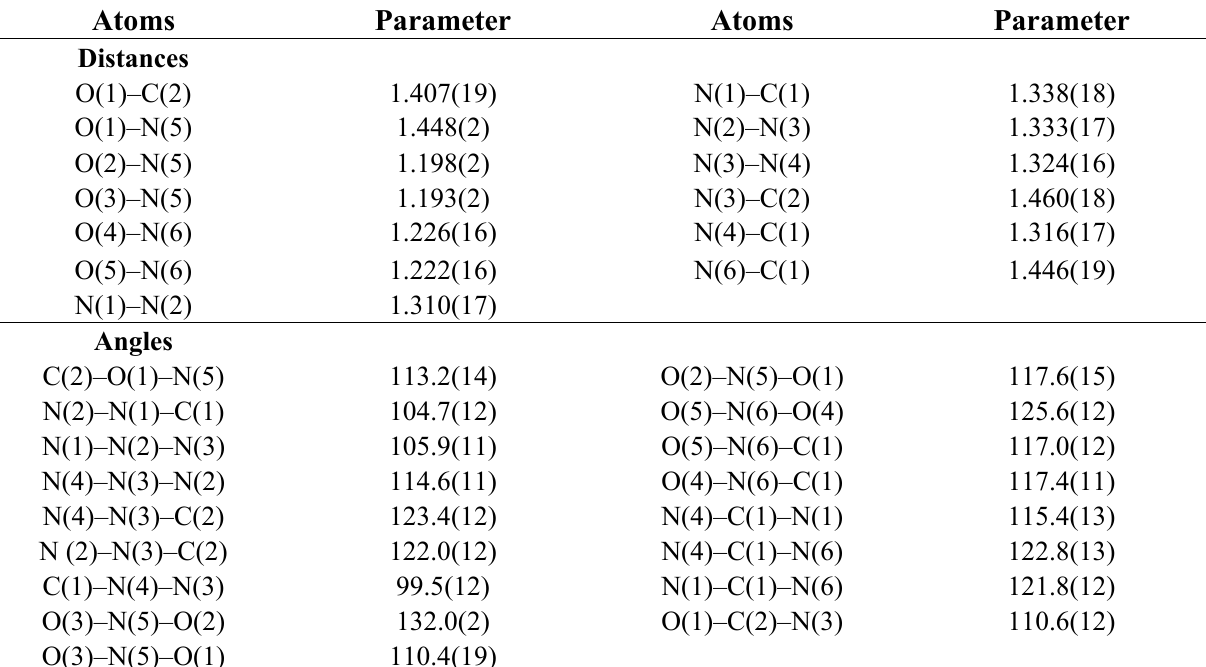
Table 2. Interatomic distances (Å) and angles (°) for compound 4